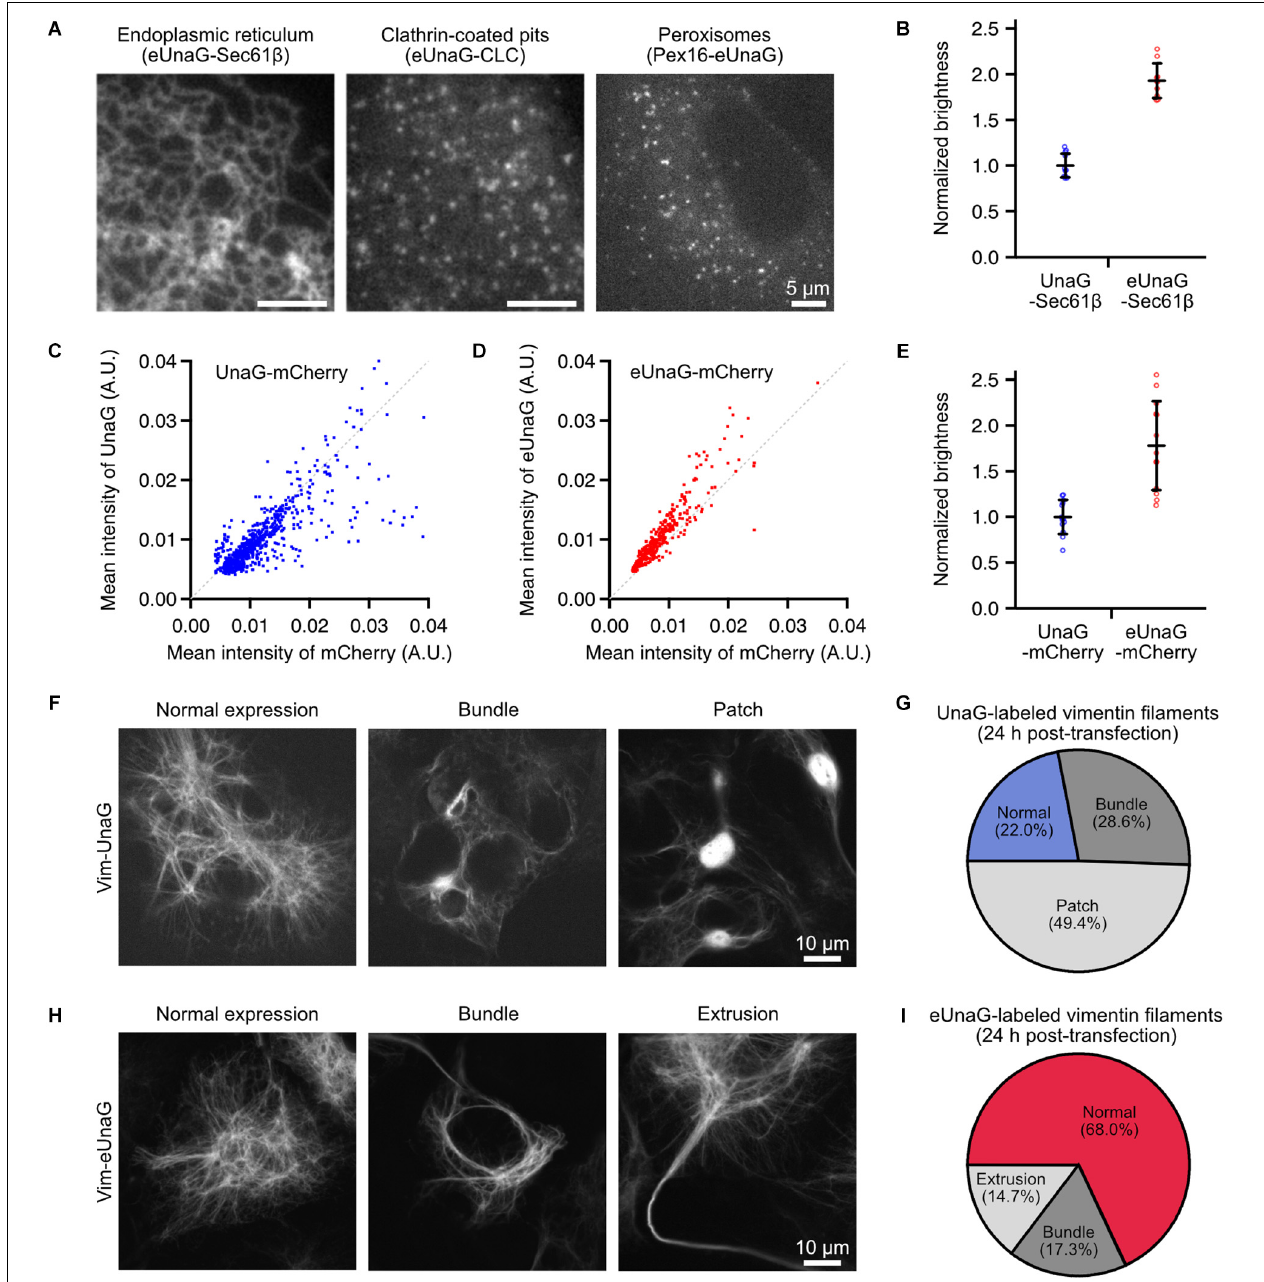
FIGURE 1 | Mammalian expression of eUnaG-labeled protein in Cos-7 cells. (A) Widefield images of eUnaG-labeled Sec61 β , CLC, and Pex16 proteins for visualization of the endoplasmic reticulum, clathrin-coated pits, and peroxisomes, respectively. (B) Fold increase in the fluorescence intensities of eUnaG [red dots, n = 10 fields of view (FOVs)] compared to those of UnaG (blue dots, n = 11 FOVs) measured from UnaG-Sec61 β fusion proteins. Each data point is the mean intensity of the entire FOV of a confocal fluorescence image containing tens of cells. (C,D) Fluorescence intensity distribution at various expression levels of cytosolic UnaG-mCherry (C) and eUnaG-mCherry (D) fusion proteins. Each data point was measured from a cell detected from a large-FOV confocal image by CellProfiler ( n = 803 for UnaG, n = 459 for eUnaG). The gray dotted line is drawn along y = x in (C,D) . (E) Fold increase in the fluorescence intensities of eUnaG (red dots, n = 13 FOVs) from those of UnaG (blue dots, n = 13 FOVs) measured from confocal images of Cos7 cells expressing cytosolic UnaG-mCherry proteins. The fluorescence intensities from UnaG and eUnaG proteins were normalized to the mCherry fluorescence intensities. Each data point is the mean intensity of the entire FOV containing tens of cells. (F) Confocal images of the expression pattern of UnaG-labeled vimentin filaments in Cos-7 cells. The cells were fixed 24 h after the transfection. (G) Phenotype distribution of cells expressing Vim-UnaG quantified from (F) ( n = 91 cells). (H) Example confocal images of the expression pattern of eUnaG-labeled vimentin filaments. The cells were fixed 24 h after the transfection as in (F) . (I) Phenotype distribution of the expression pattern of Vim-eUnaG proteins obtained from (H) ( n = 75 cells). Error bars: SDs.